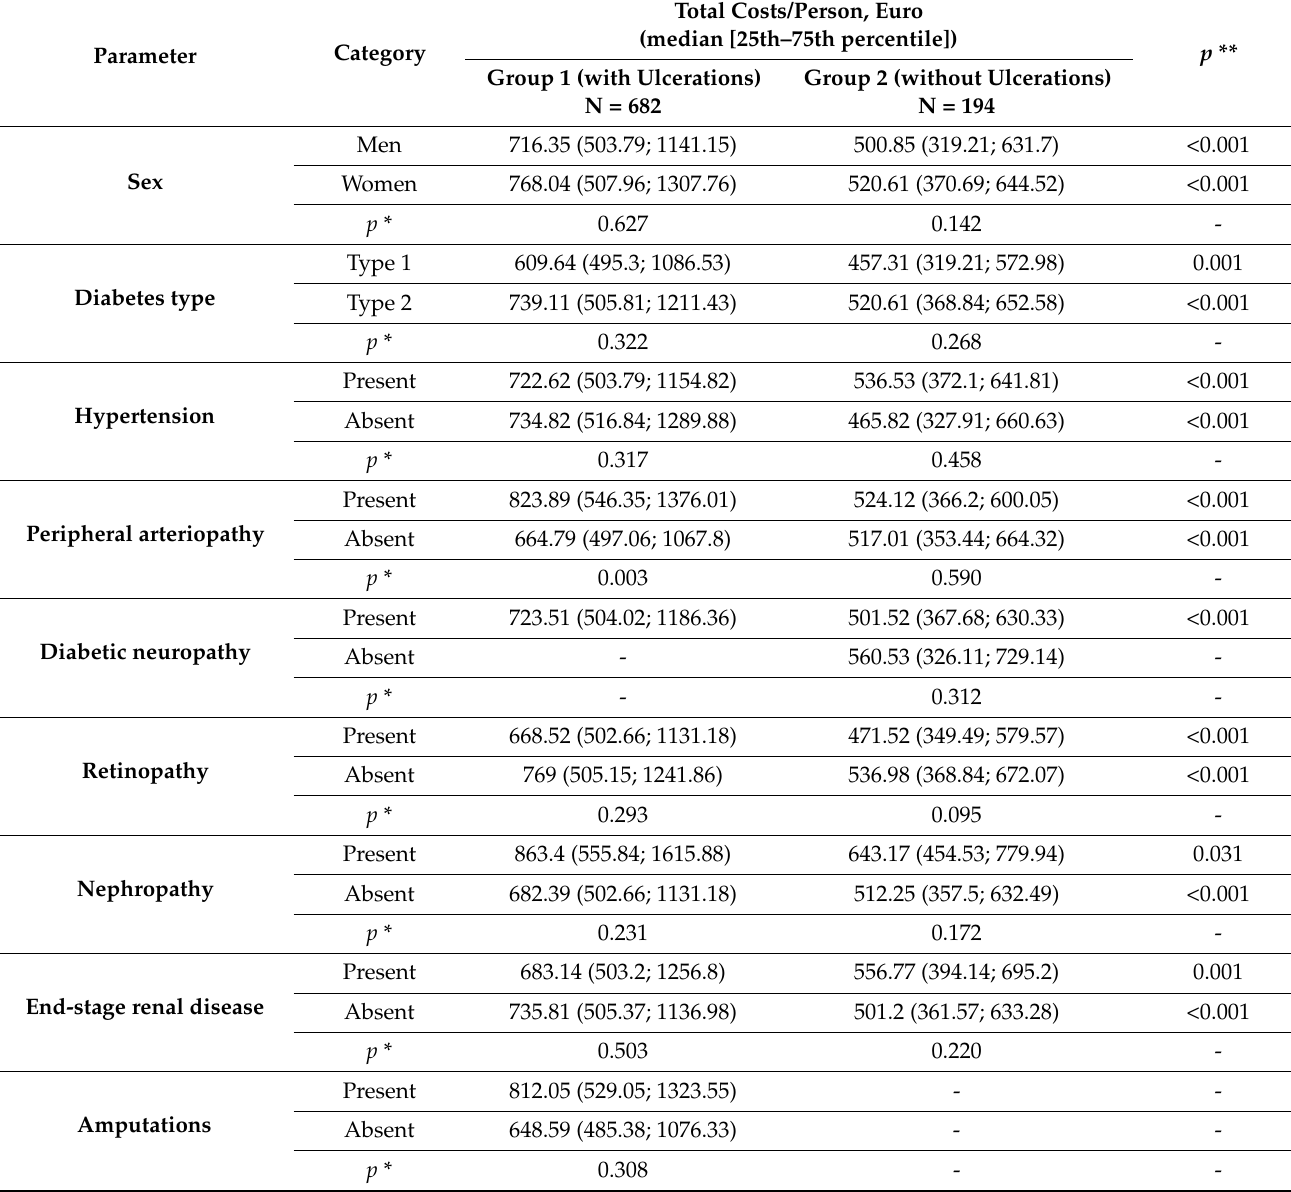
Table 3. Cost analysis by study